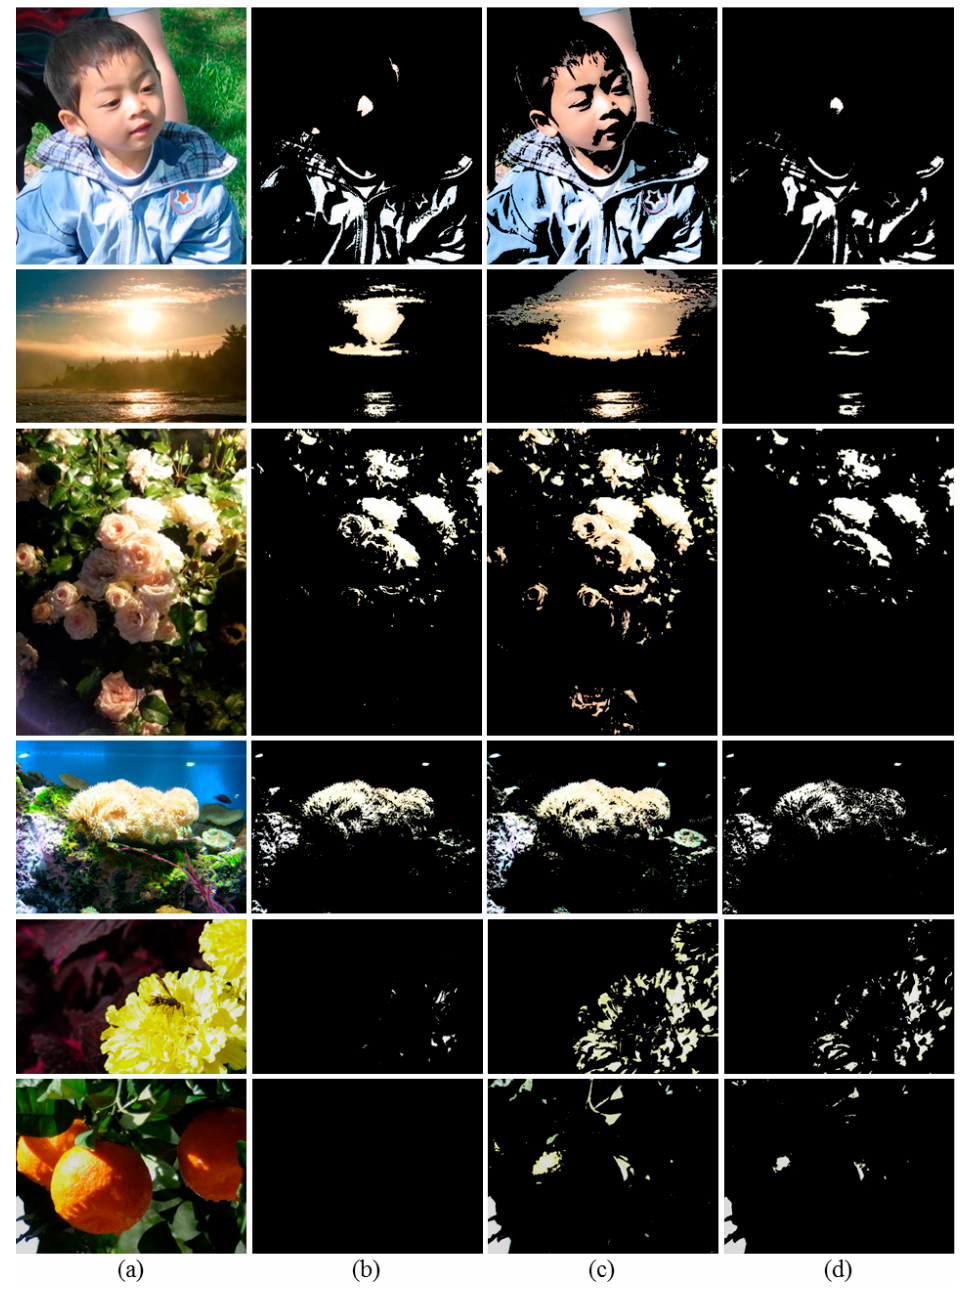
Figure 5. Comparison of OER detection results. ( a ) Original Kid , Sky , Roses , Coral , Flower and bee , and Oranges images; ( b ) OERs detected using the brightness thresholding method (Y ≥ 230) [9]; ( c ) OERs detected using the over-exposed map based thresholding method [10]; ( d ) Perceived OERs detected using the proposed